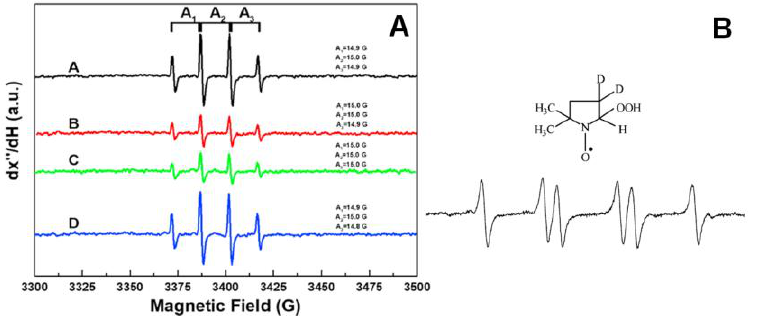
Figure 9. To monitor radical species with very short half-life times, such as hydroxyl ( • OH) or superoxide ( • O 2 − ) radicals, spin-trap molecules such as 5,5-dimethyl-pyrroline N-oxide (DMPO) are needed. Figure 9 depicts the typical signals of ( A ) DMPO- • OH adduct, where the characteristic hyperfine splitting of the hydroxyl quartet (A 1 , A 2 , A 3 ) is displayed. (A-black line) no antioxidant; (B-red line) in the presence of Rosmarinic Acid; (C-green line) in the presence of RC; (D-blue line) in the presence of RCG. ( B ) DMPO- • OOH adduct. Reprinted (adapted) with permission from [95,96]. Copyright 2023 American Chemical Society / Elsevier.